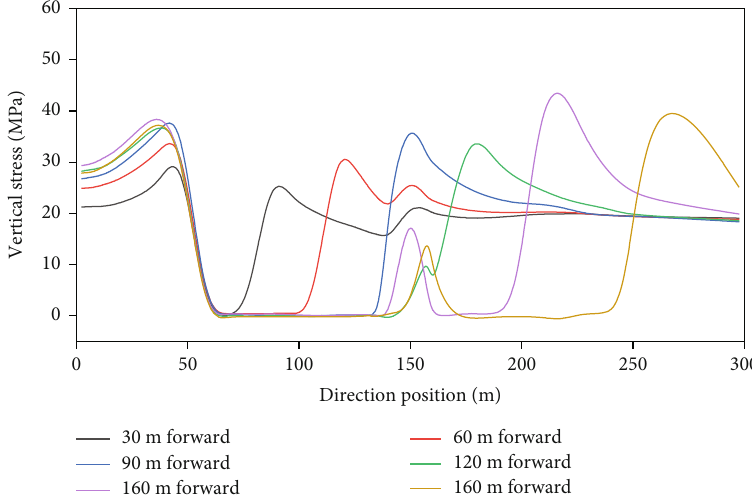
Figure 11: The vertical stress distribution law of the No. 8 coal seam roof when the working face advances at di ff erent